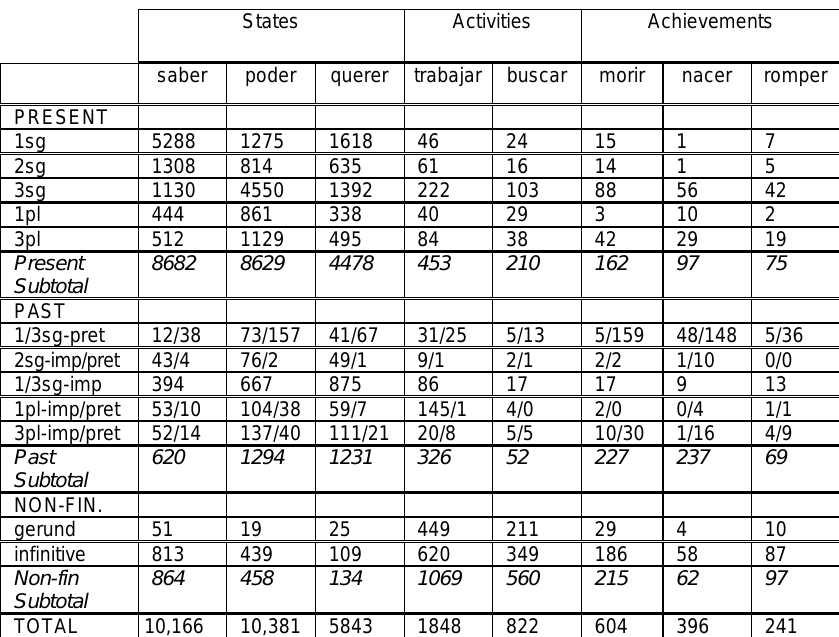
Table 2: The distribution of forms for representative State, Activity, and Achievement